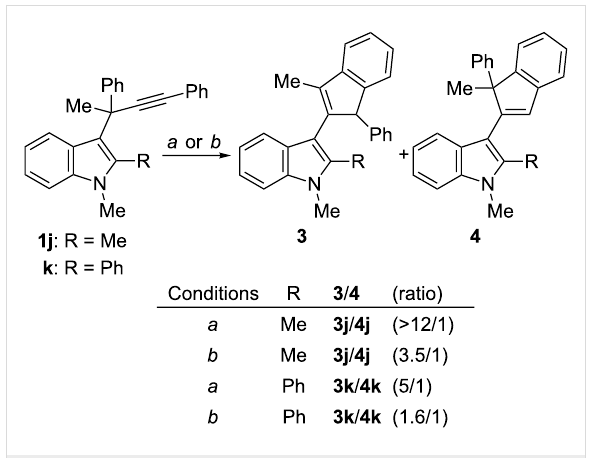
Scheme 3: Comparison of the reactivity of C-2 substituted indoles 1j and 1k . Conditions: a ) (Ph 3 P)AuCl/AgSbF 6 (5 mol %), CH 2 Cl 2 , rt; b